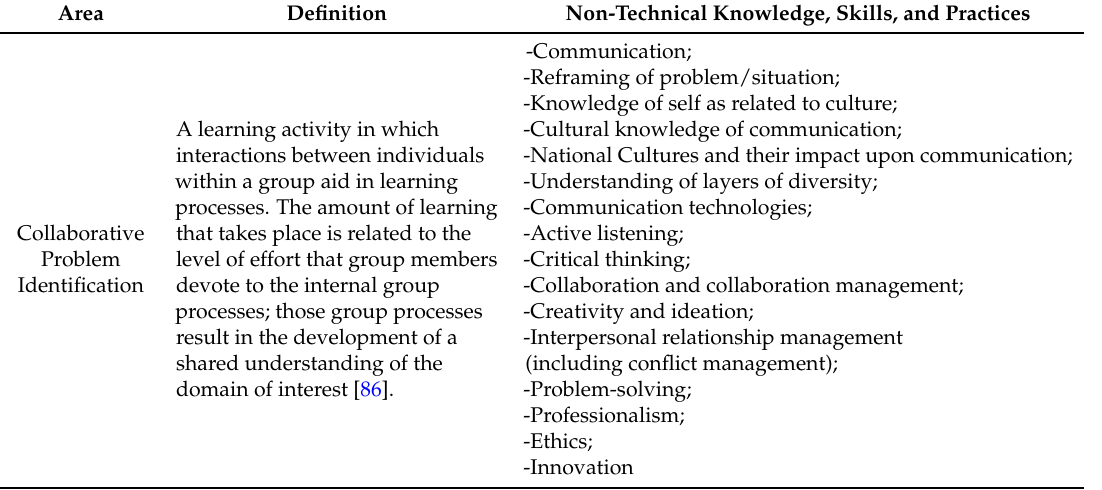
Table 3. Typology of non-technical skills for necessary for step 1: concept-problem identification process. Area